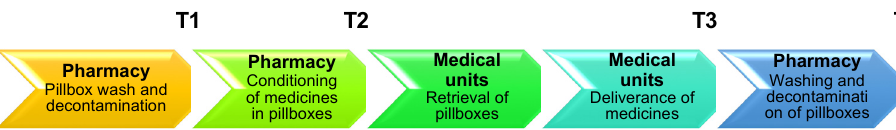
Figure 1. Workflow of the experiment. T1, T2, T3 and T4 represent the different sampling times. T1: after cleaning, T2: after use for medicine preparation in the pharmacy, T3: upon return from the medical unit, T4: after washing in the dishwasher.